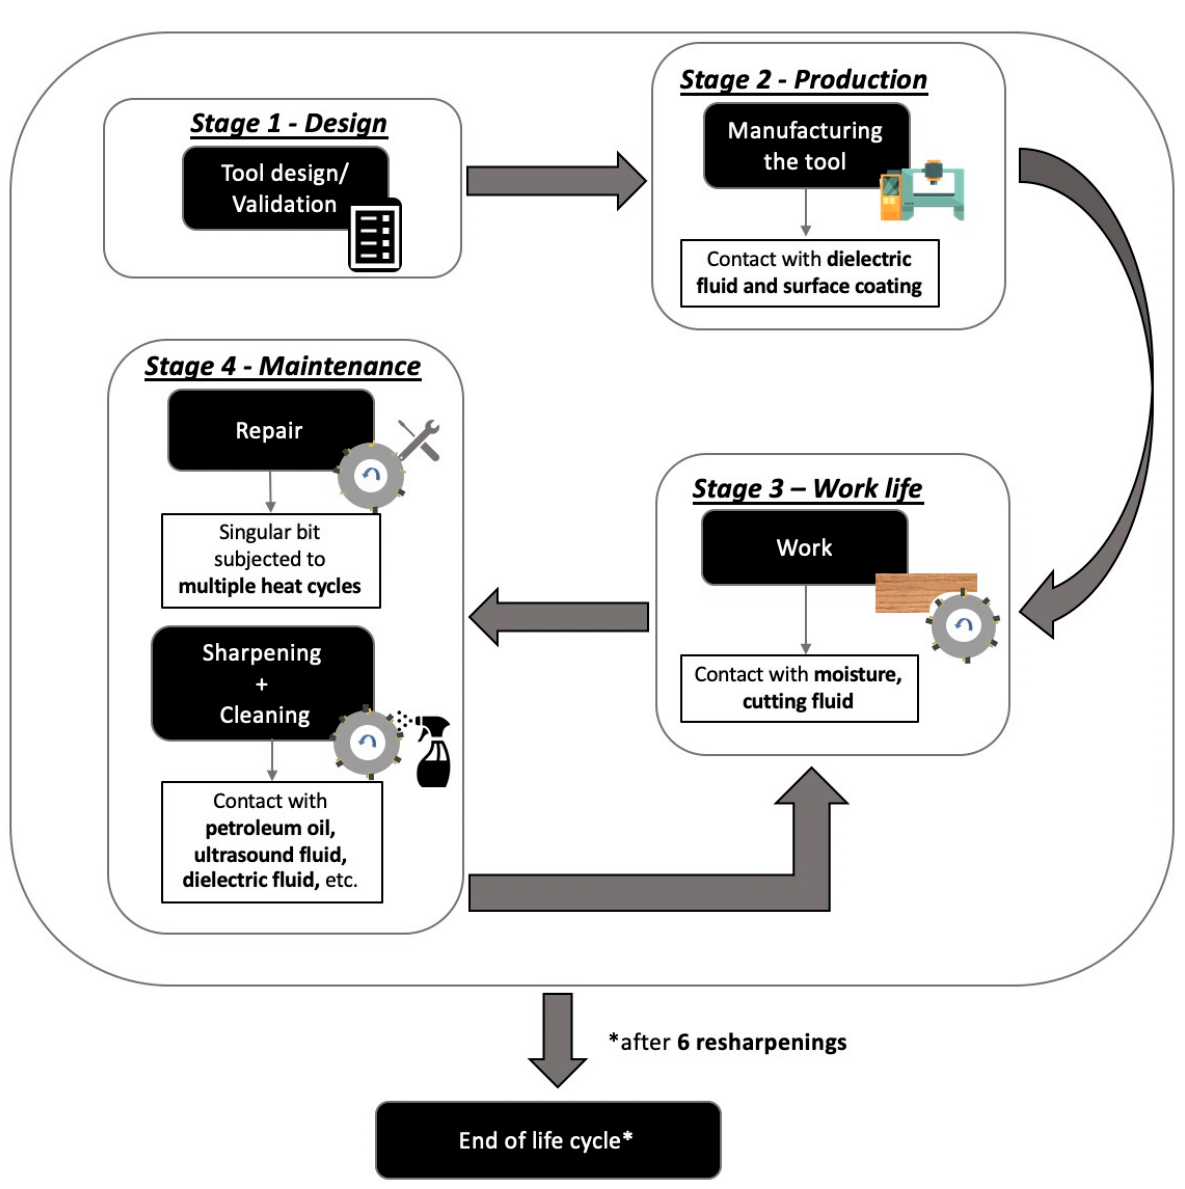
Figure 1. Typical life cycle of milling tools. A common tool life cycle is composed of four stages: the design (Stage 1), production (Stage 2), work life (Stage 3), and maintenance (Stage 4). Stages 3 and 4 alternate for a few cycles until a tool reaches its end of life.